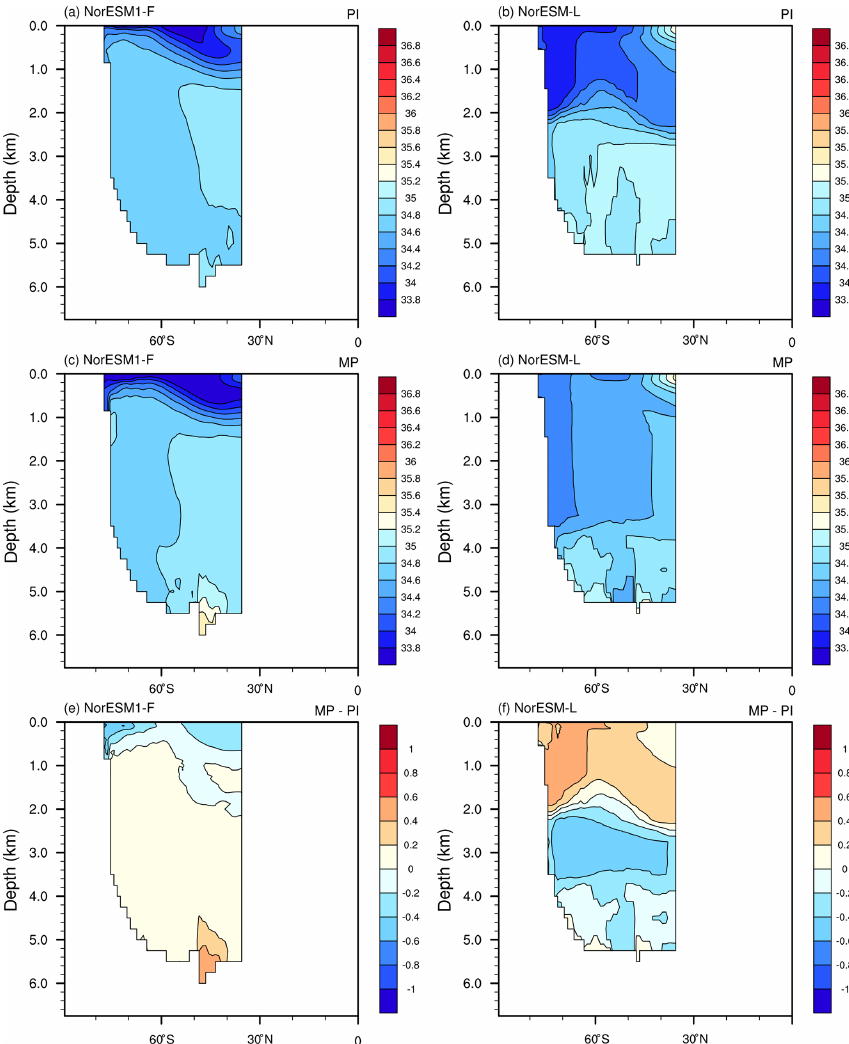
Figure 8. Climatological Southern Ocean salinity (units: gkg − 1 ) derived from the preindustrial (a, b) and Pliocene (c, d) experiments and their differences (e, f) according to NorESM1-F (a, c, e) and NorESM-L (b, d, f) . Table 5. Similar to Table 3, but for anomalies simulated according to NorESM-L between PlioMIP1 and PlioMIP2.